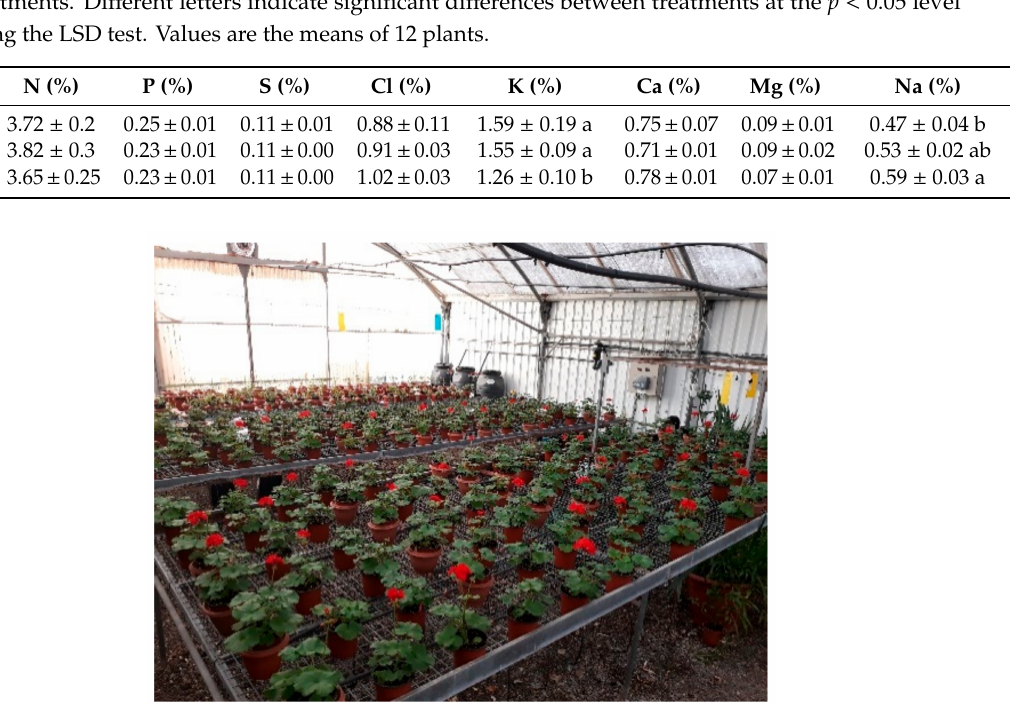
Table 3. N, P, S, Cl, K, Ca, Mg and Na concentration in the leaves at the end of the trial for the C2 (fertigation EC 2.0 dS m − 1 ), C3.0 (fertigation EC 3.0 dS m − 1 ), and C3.5 (fertigation EC 3.5 dS m − 1 )